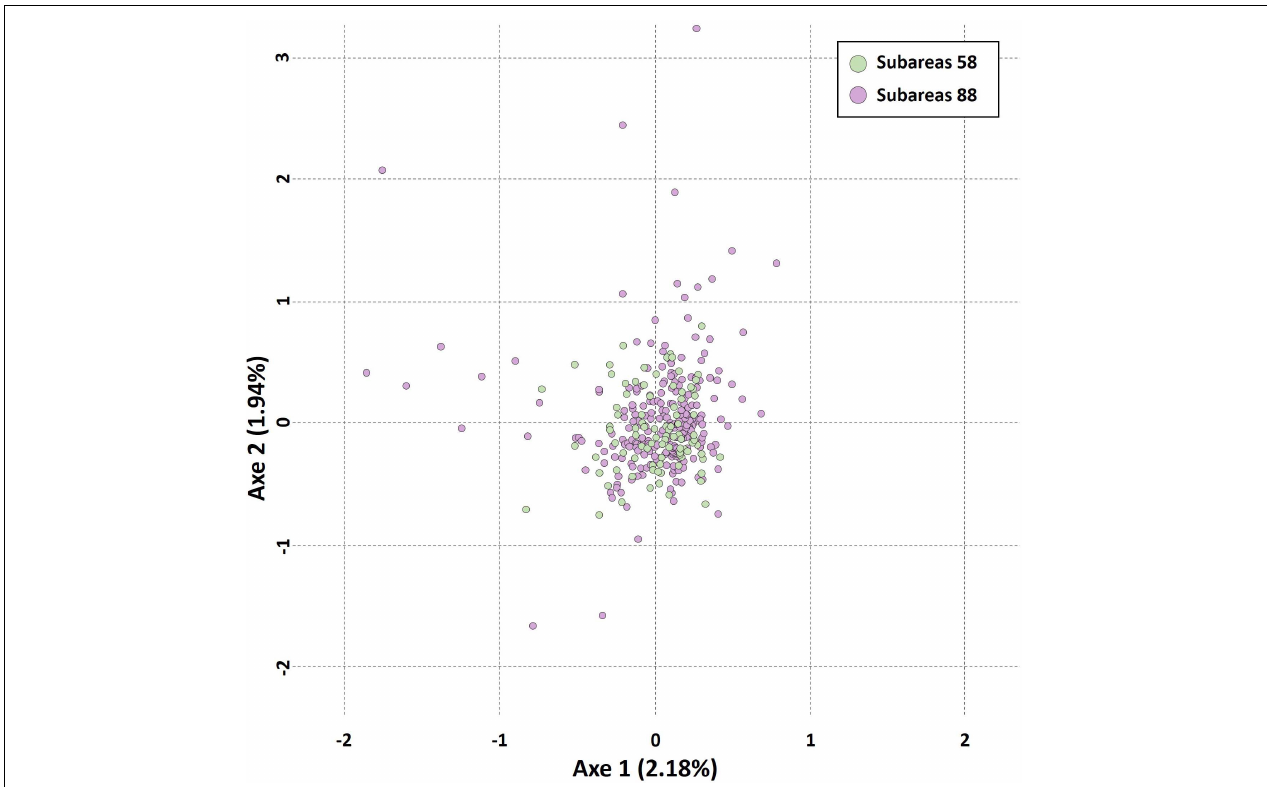
FIGURE 6 | Results of factorial correspondence analysis (FCA) showing multivariate relationships between the Subareas 58 and 88 of Dissostichus mawsoni based on seven microsatellite allelic variation. Circles in green represent Subareas 58, and those in purple represent Subareas 88.